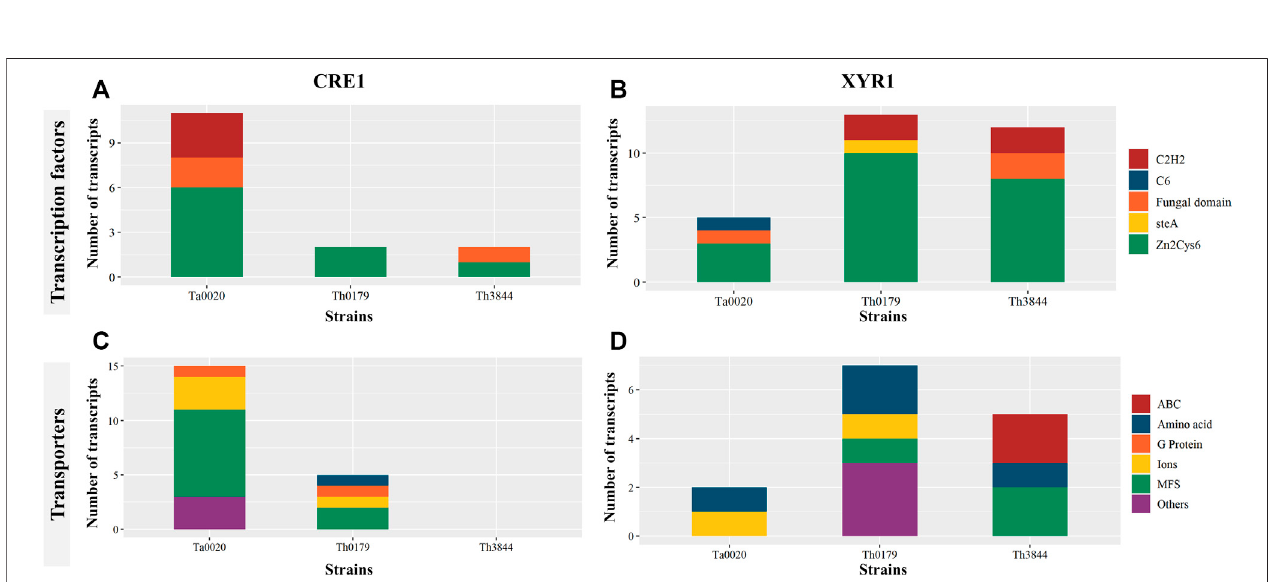
FIGURE 4 | Distribution of CAZyme families in the cre1 and xyr1 groups. Classi fi cation of CAZyme families coexpressed with cre1 (A) and xyr1 (B) in Th3844, Th0179,and Ta0020 and quanti fi cationofeach CAZyme family inthe cre1 groups (C) and xyr1 groups (D) .Illustrationshowing thatthe xyr1 and cre1 groupspresented CAZymes from the GH family in all the evaluated strains with different numbers of transcripts. Overall, Ta0020 had a high number of GHs belonging to family 18, coexpressed with the cre1 transcript, while Th0179 exhibited a signi fi cant amount of GT90. Different CAZyme pro fi les were observed in the xyr1 groups, and Th3844 showed the highest diversity of CAZyme families. PL: polysaccharide lyase; GH: glycoside hydrolase; GT: glycosyltransferase; CE: carbohydrate esterase; Ta0020: T. atroviride CBMAI-0020; Th0179: T. harzianum CBMAI-0179; Th3844: T. harzianum IOC-3844.